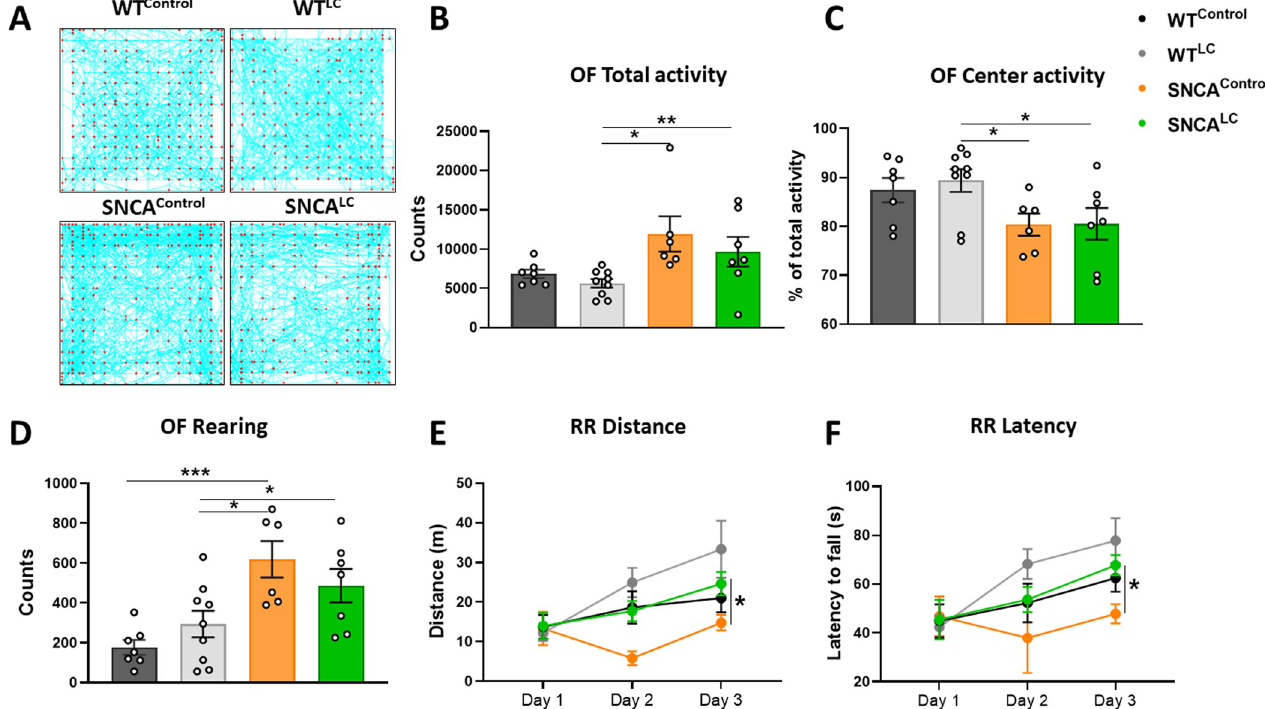
Fig 2. Improved motor function after 6 weeks of LC-NE stimulation. A- Representative track (blue) and rearing (red dots) patterns of all groups in open field test. B- Total activity, percentage of center activity, and rearing in open field test (n = 6–9). C- Distance and latency to fall over the period of 3 days in rotarod test (n = 6–9). ��� p < 0.0001, �� p < 0.001, � p < 0.05, all values denote means ± SEM.